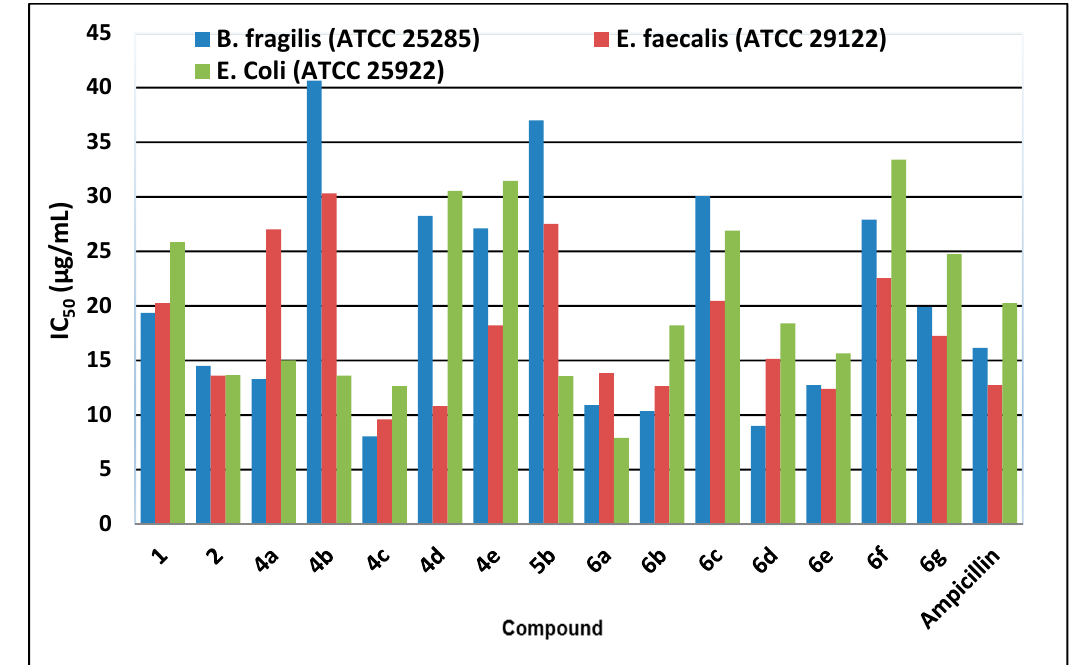
Figure 1. Evaluation of the antibacterial activity of the synthesized quinoxalinone and quinazolinone derivatives by the determination of their IC 50 values (µg/mL).